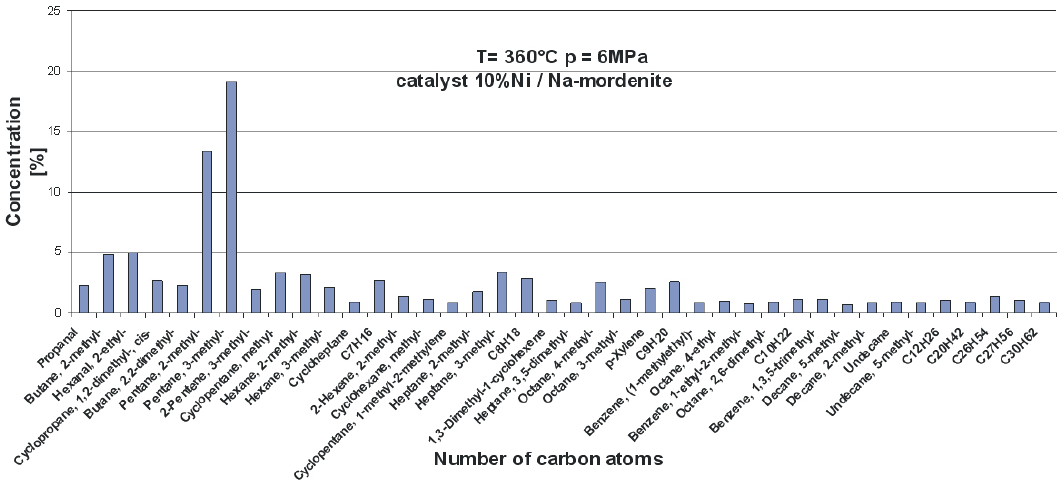
Figure 6. Hydroconversion of LTP56-H paraffin conducted for 4 h at 380°C without catalyst and in the pressure range 120-380 bar (paraffin dissolved with hexane).